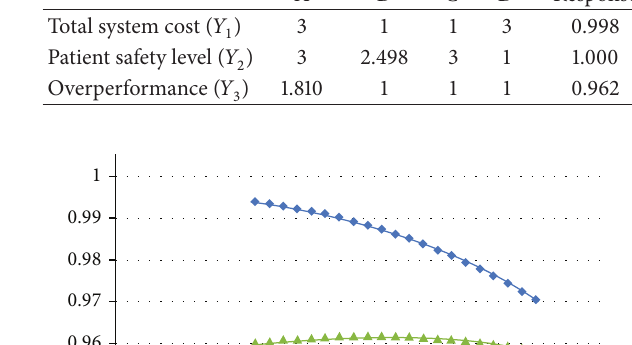
Table 2: The optimal parameter settings for 𝑌 1 , 𝑌 2 , and 𝑌 3 . 𝐴